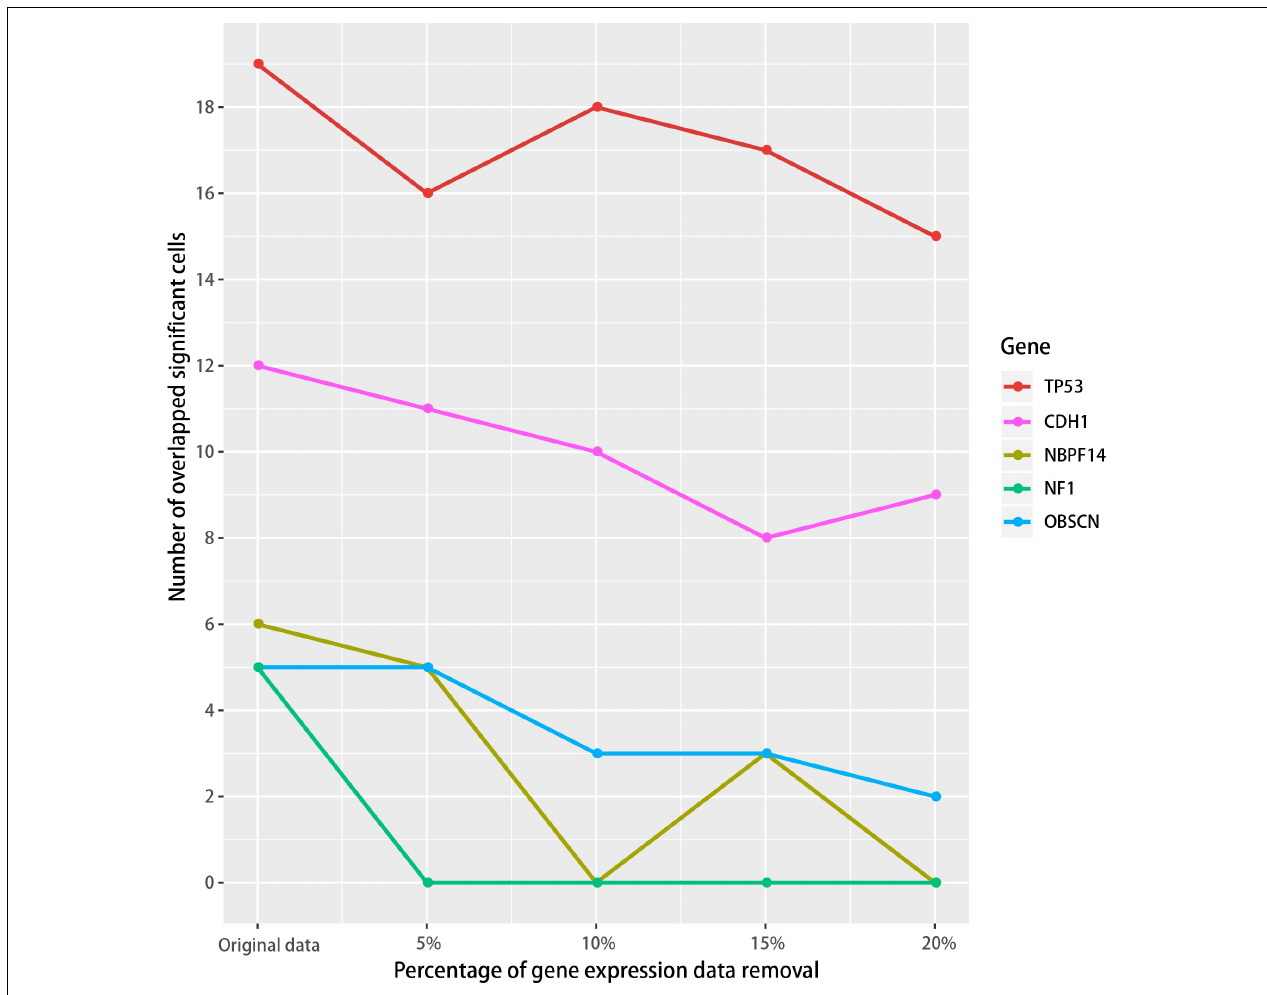
FIGURE 6 | Robustness analysis of the SMDIC method. The gene expression values were randomly removed from 5 to 20% at 5% intervals. For each removal, the overlapped number of the immune cells with the original results was calculated for the mutation genes which activate at least five immune